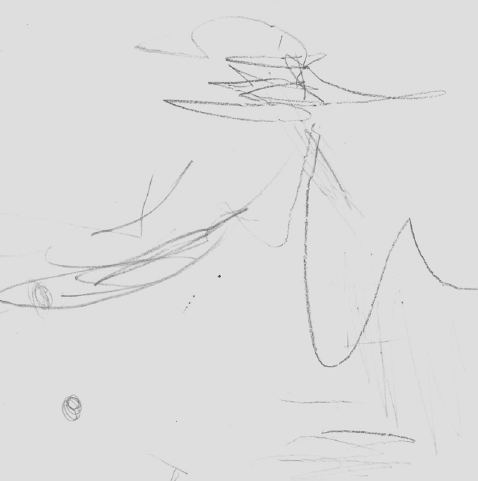
Figura 2. Desenho produzido pela criança de um ano e seis meses.